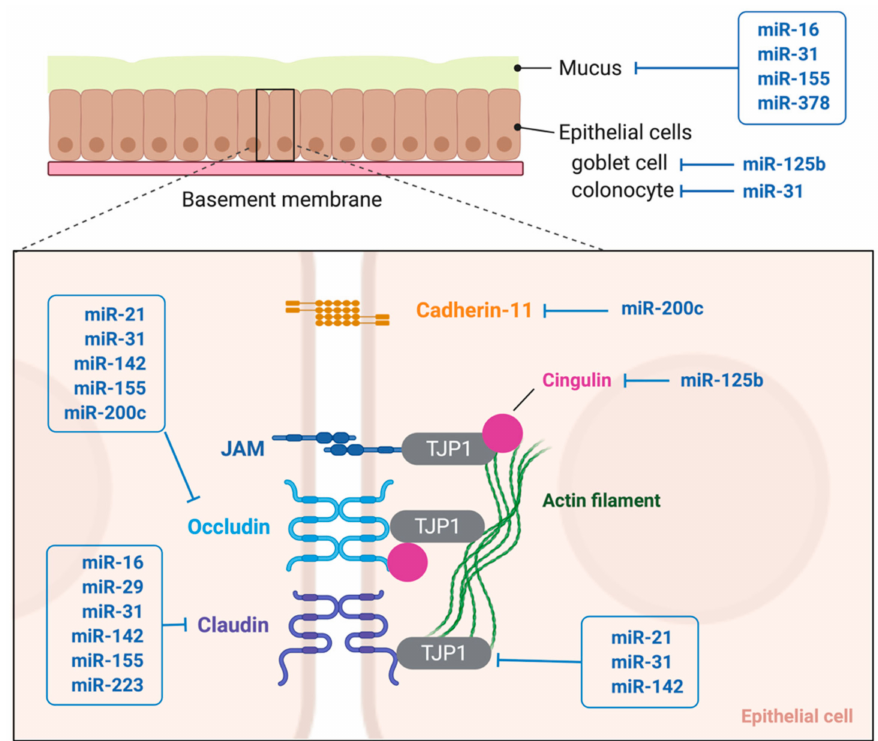
Figure 2. Potential roles of UC-associated miRNAs in epithelial barrier disruption. TJP1, tight junction protein